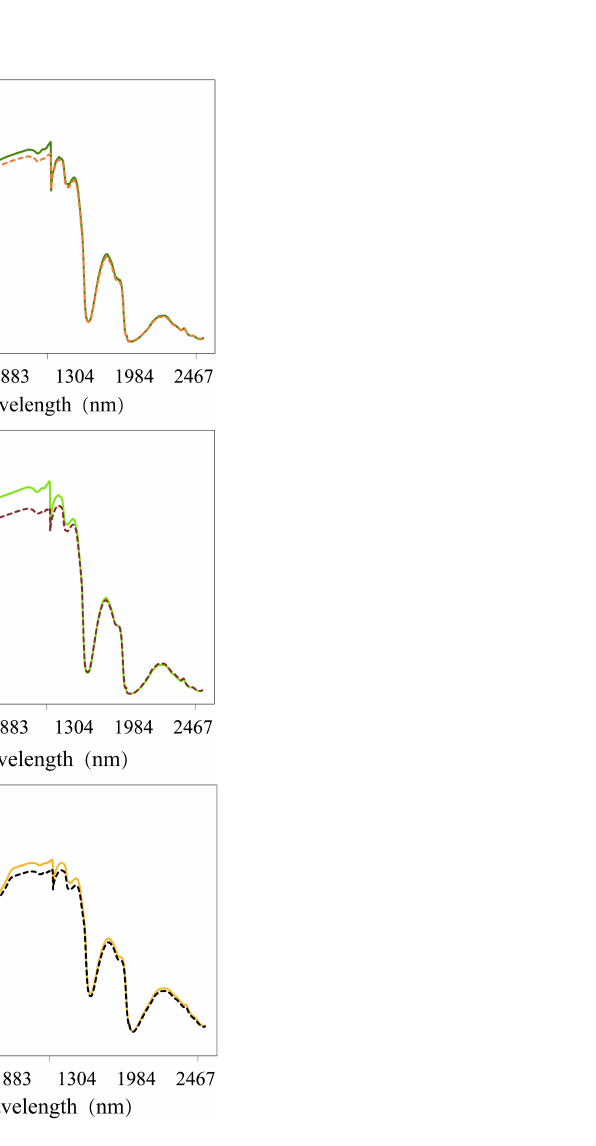
FIGURE 6 Average re fl ectance spectra of cotton leaves under different drought conditions and growth stages. (A) The fl owering stage of cotton under normal conditions and drought stress; (B) The boll setting stage of cotton under normal conditions and drought stress; (C) The boll opening stage of cotton under normal conditions and drought stress; Each line represents the average value of 240 re fl ectance spectra of 80 different cotton varieties. Solid lines represent normal conditions; dashed lines represent drought